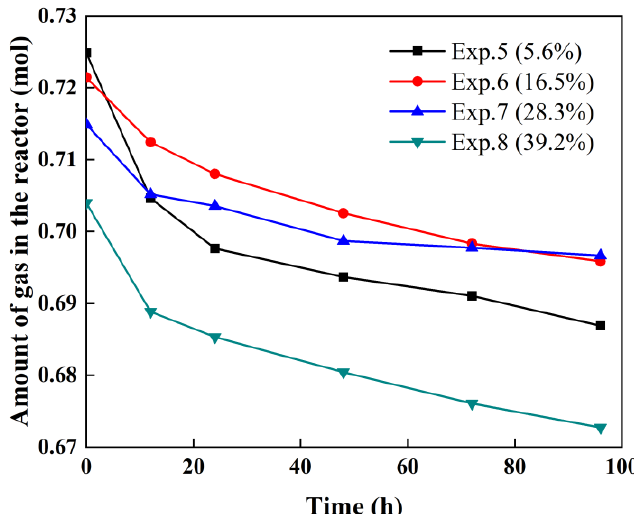
Figure 9. Variation in the total gas content in the reactor for Experiments 5, 6, 7, and 8. Calculated by Equation (1), the reductions in gas in the reactor for Experiments 5–8 are 0.038, 0.0256, 0.0183, and 0.0321 mol, respectively, which is the amount of gas consumed